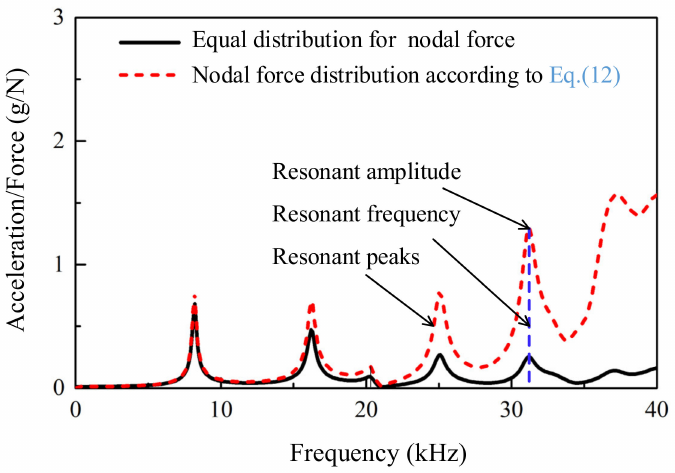
Figure 16. Comparison of nodal force distribution methods (source elaborated by authors).